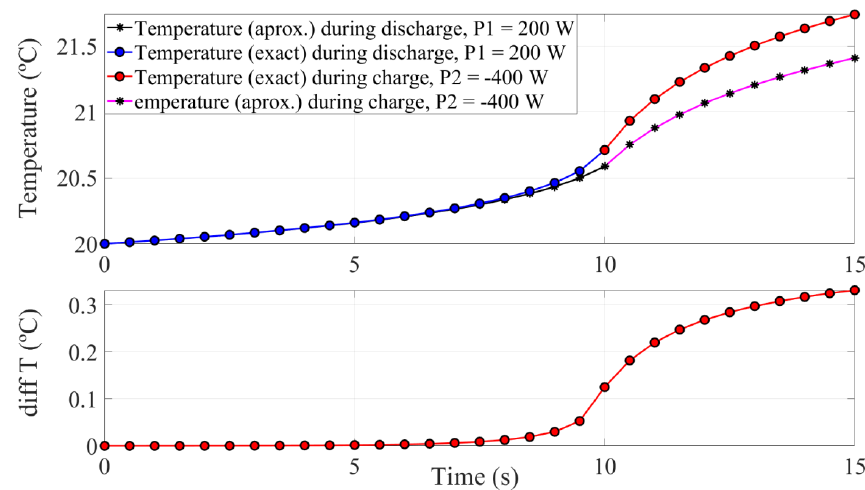
Figure 6. Top chart: Temperature of the cell obtained by using Equations (28)–(34) and the approximate equations given in [56] for discharge and charge at high power. Bottom chart: Temperature difference between both solutions.